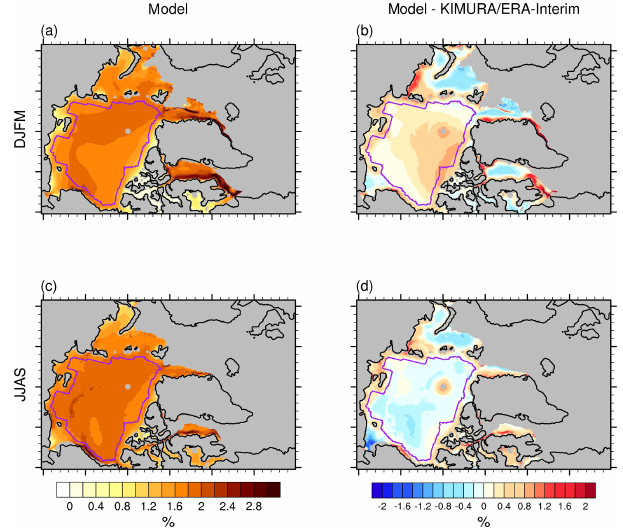
Figure 3. Mean spatial pattern of wind factor (%) in the model (ensemble mean of HIRHAM–NAOSIM 2.0) for the 2003– 2014 (a) winter (DJFM) and (c) summer (JJAS). Panels (b) and (d) are the model differences to the observation/reanalysis (model − KIMURA/ERA-I) for winter and summer respectively. The purple line indicates the study domain used for the basin-wide